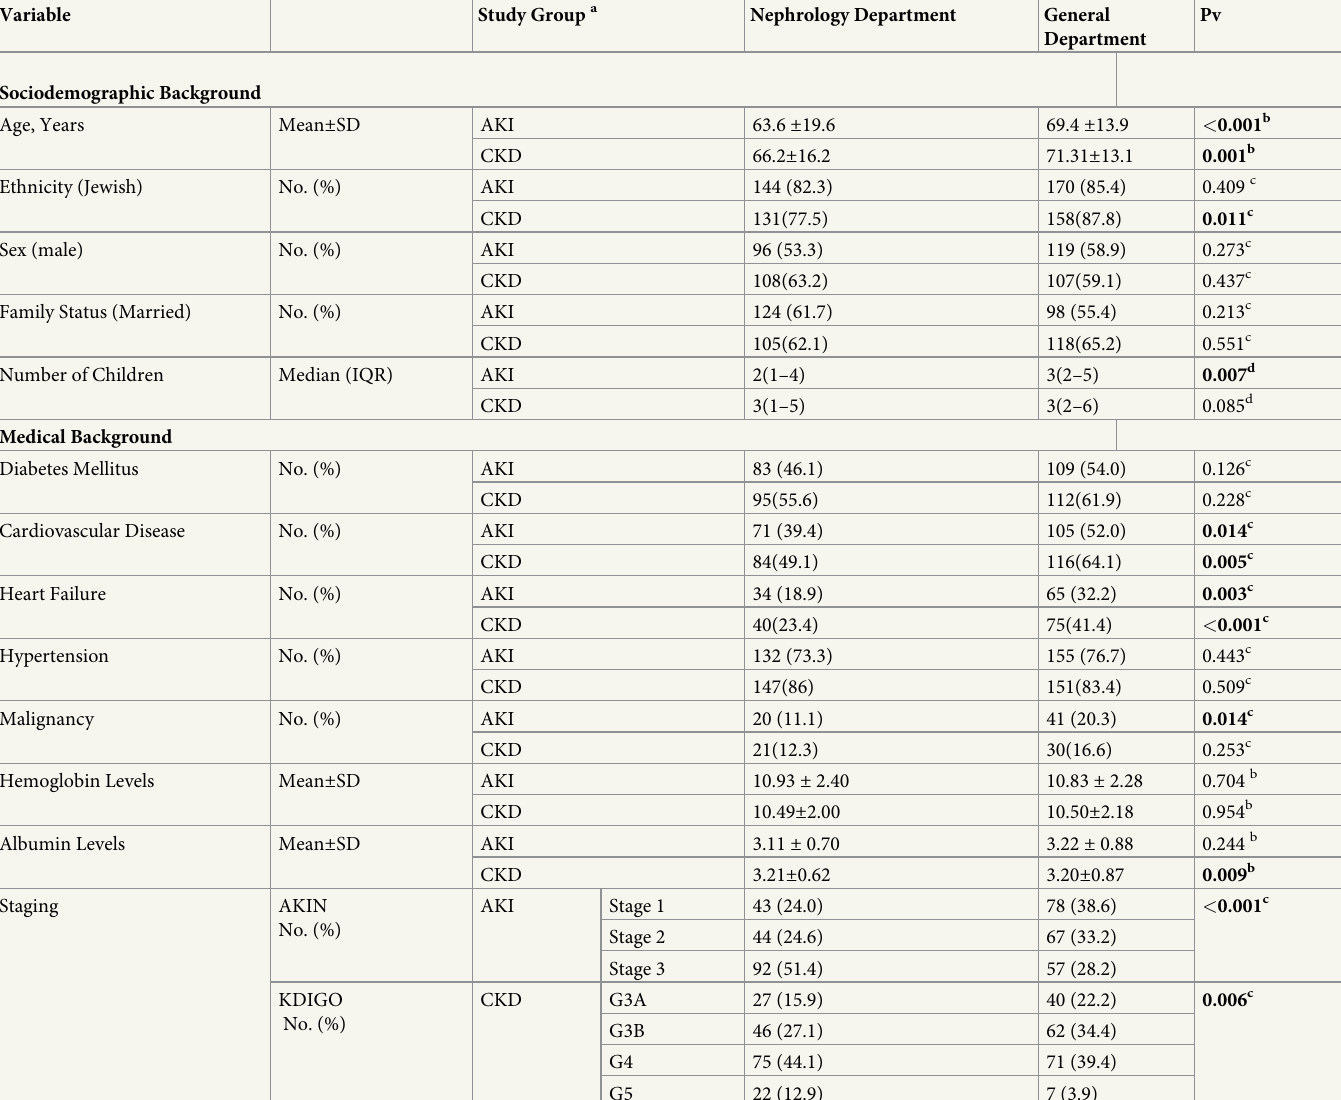
Table 1. Clinical and sociodemographic characteristics of patients.